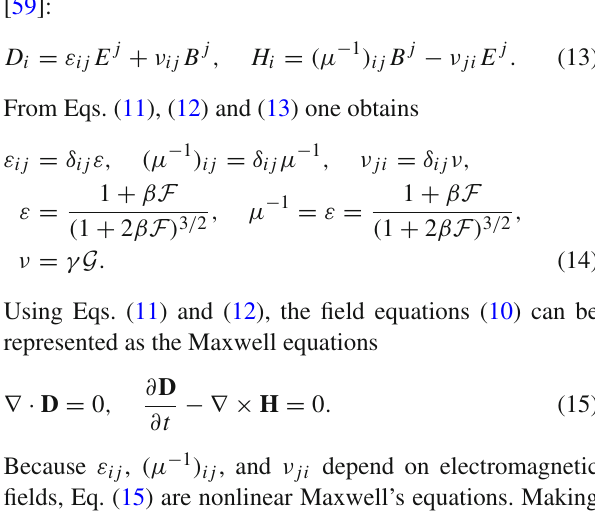
Fig. 1 The function y vs.